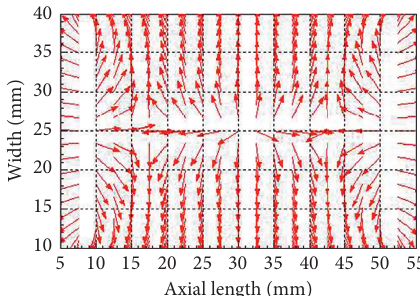
Figure 7: Friction slip field in the contact